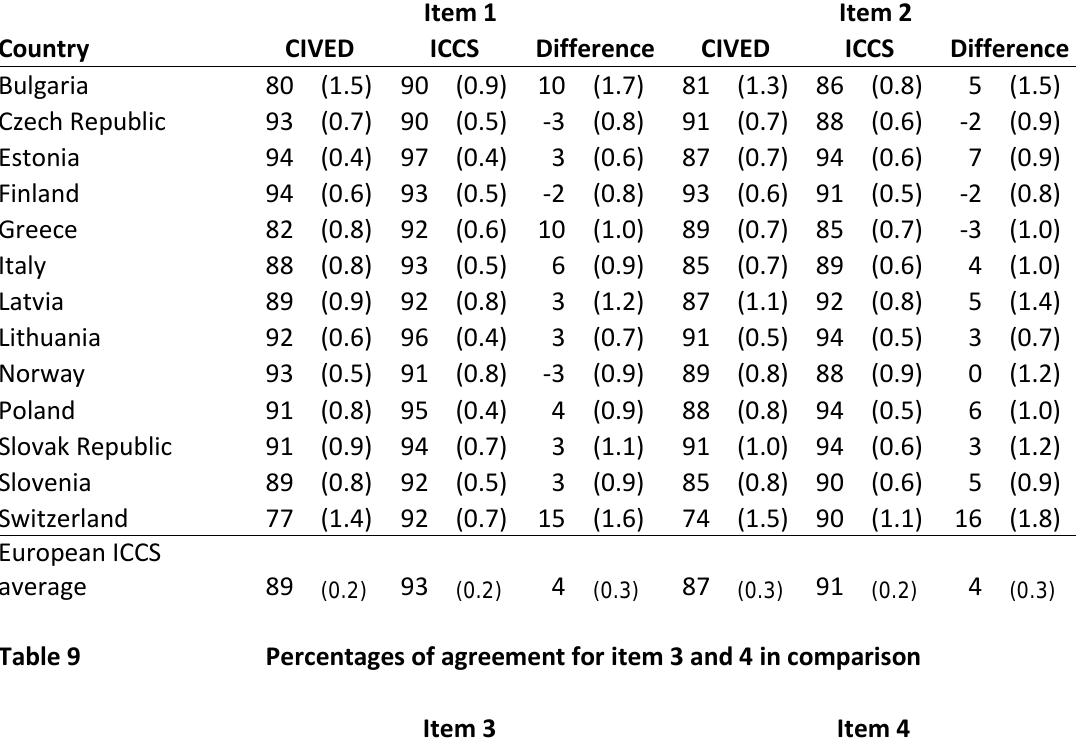
Percentages of agreement for item 1 and 2 in comparison Item 1 Item 2